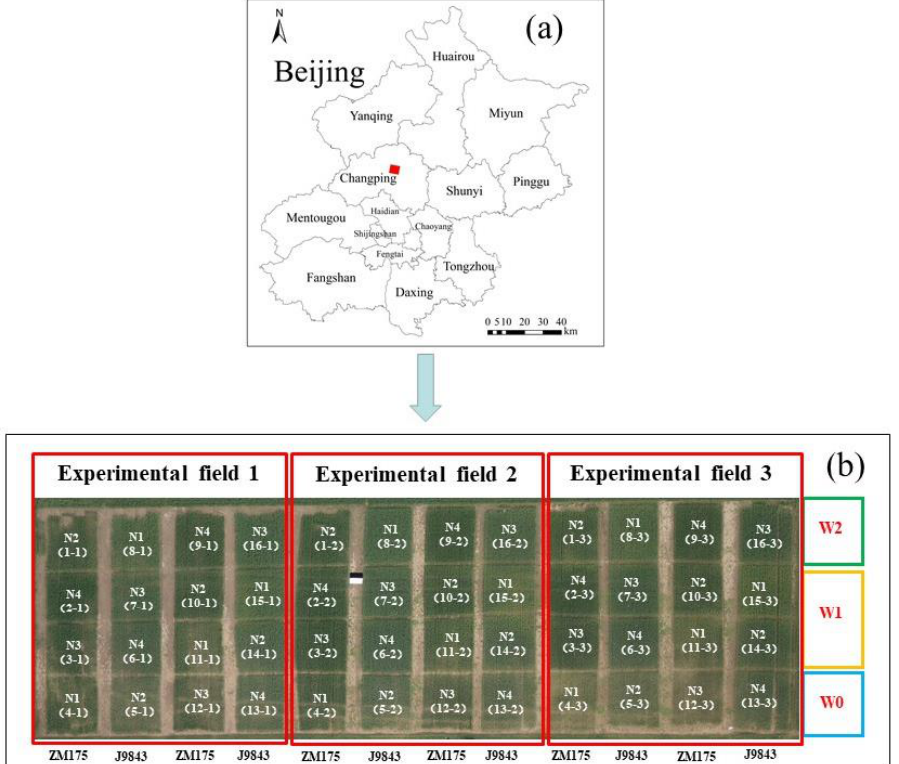
Figure 1. ( a ) Location of the test area (red rectangle) in Beijing, China. ( b ) Design of experimental field and distribution of plots. N1, N2, N3, and N4 refer to nitrogen fertilizer applications of 0, 195, 390, and 780 kg/ha, respectively. W0, W1, and W2 refer to horizontal water irrigation treatments of normal rainfall only, normal rainfall plus 100 mm water irrigation, and normal rainfall plus 200 mm water irrigation, respectively.